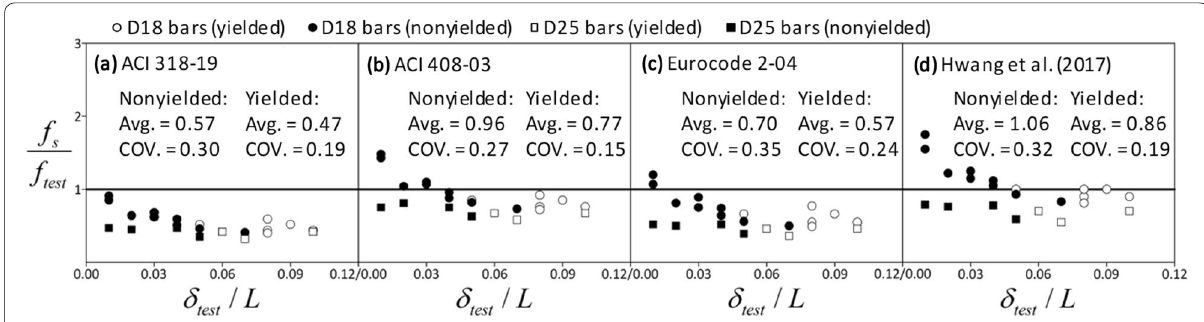
Fig. 11 Comparison of tested bar stress with predictions using static material